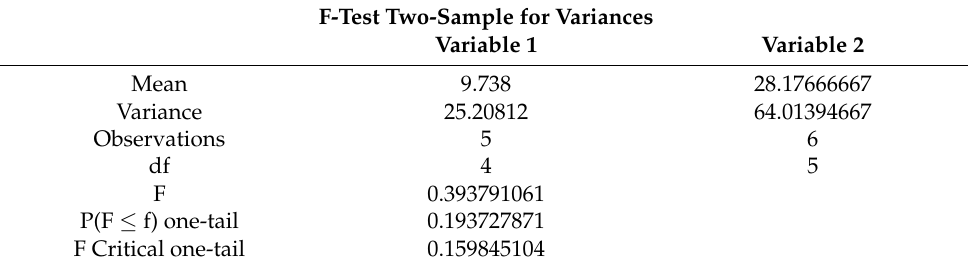
Table 5. Results of F-Test for